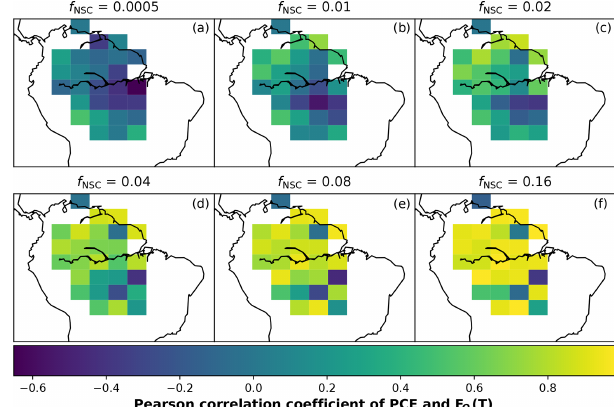
Figure 3. The Pearson correlation coefficient of simulated plant carbon expenditure (PCE) and driving gross primary productivity (GPP) for different initialised carbohydrate contents as a fraction ( f NSC ) of grid box biomass. This gives an indication of how impor- tant a driver GPP is for PCE in each grid box.